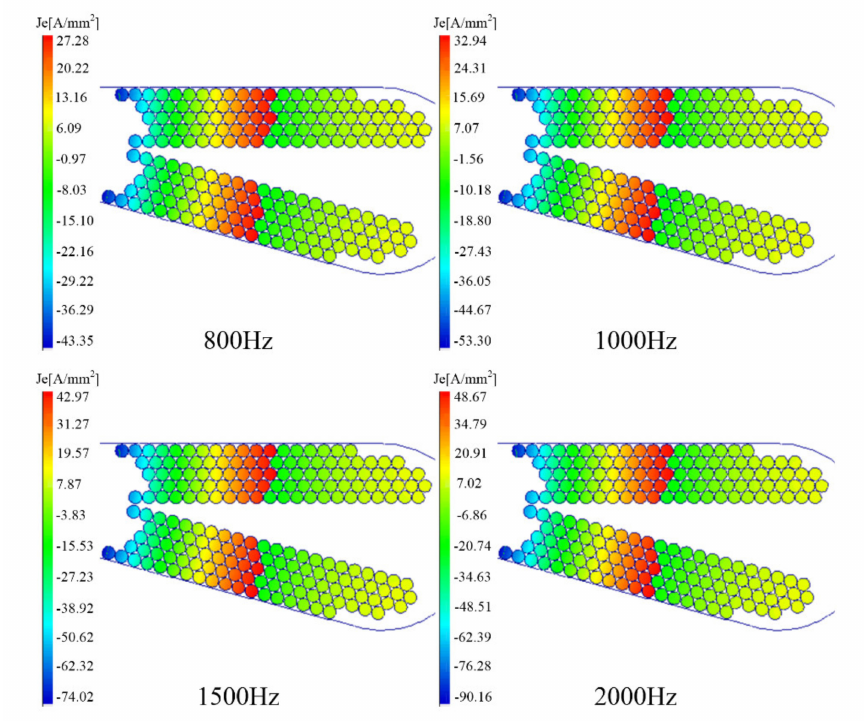
Figure 3. Current density distribution at different frequencies.